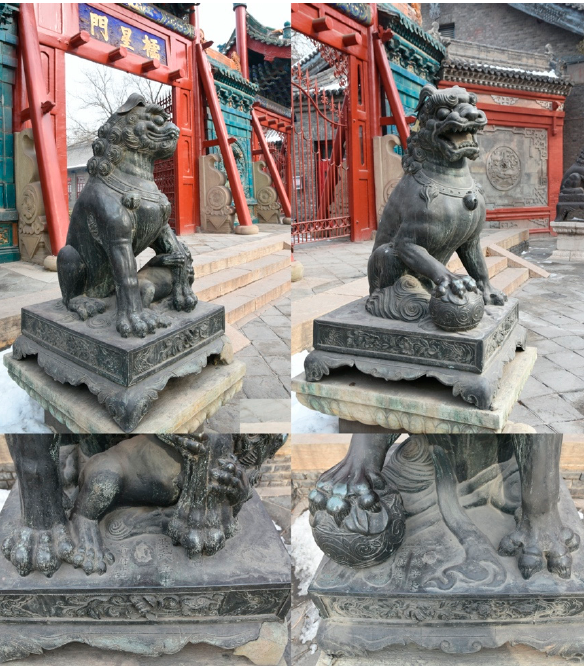
Figure 3. Iron lions in front of the Lingxing Gate of Wenmiao inscribed “made by the princely establishment of Jin in Xinwei Year of Hongwu” 洪武辛未晉府造 (photo by author, 18 January 2020). Chongshansi suffered rises and declines during the Ming Dynasty. After Prince